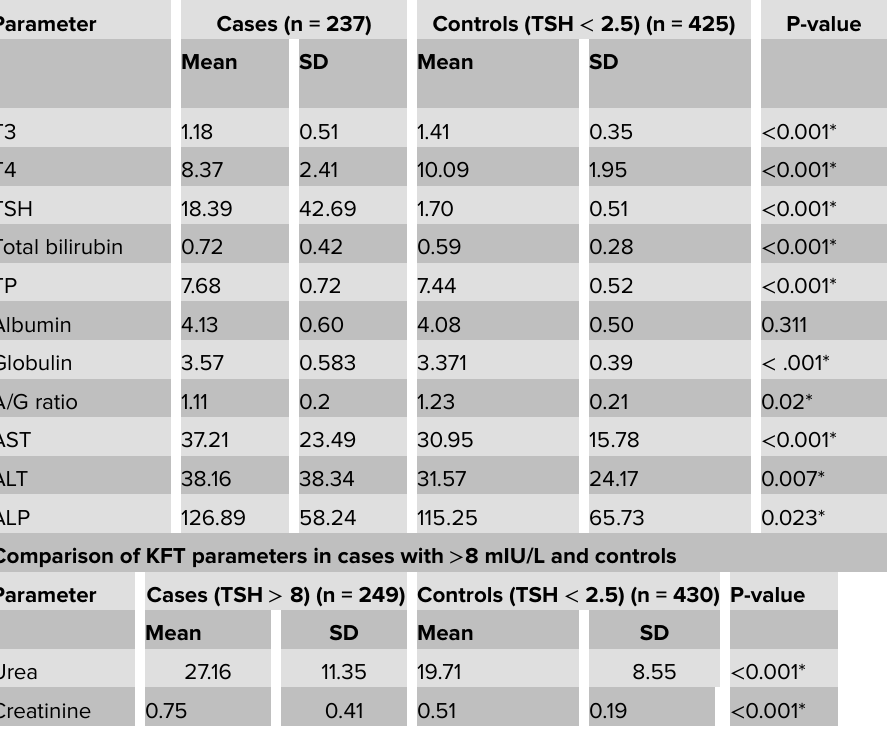
Table 3: Comparison of LFT parameters in cases with TSH > 8 and